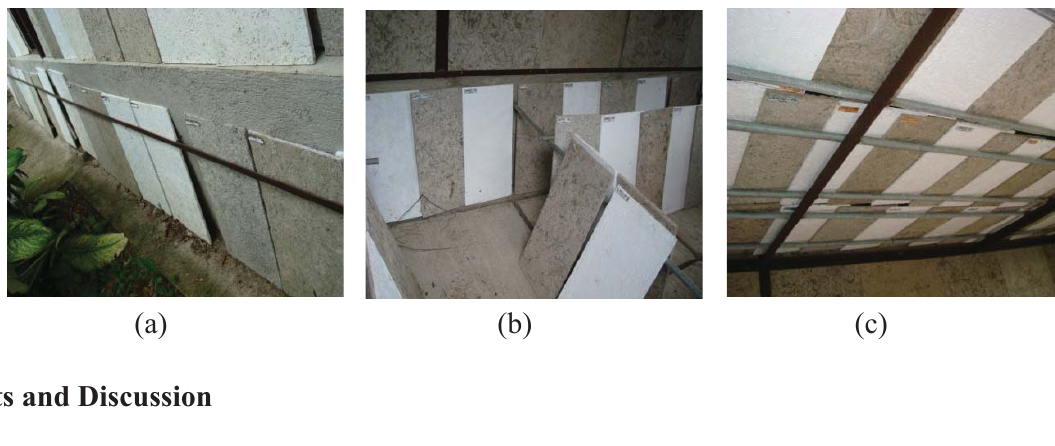
Figure 2. Experimental set-up of painted and unpainted WWCBs as: ( a ) siding, ( b ) paneling and ( c ) ceiling; under field conditions.